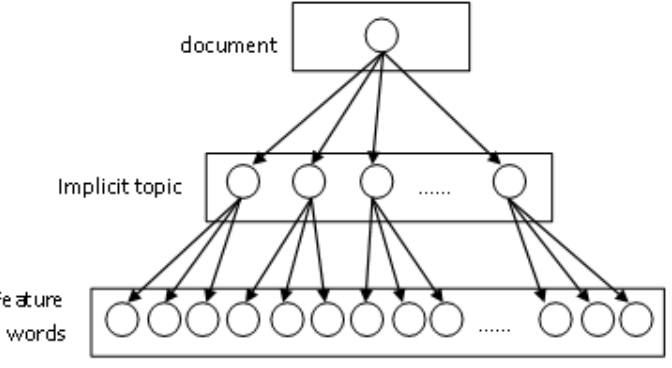
Fig. 2. Three-layer topology of Latent Dirichlet Allocation topic mode